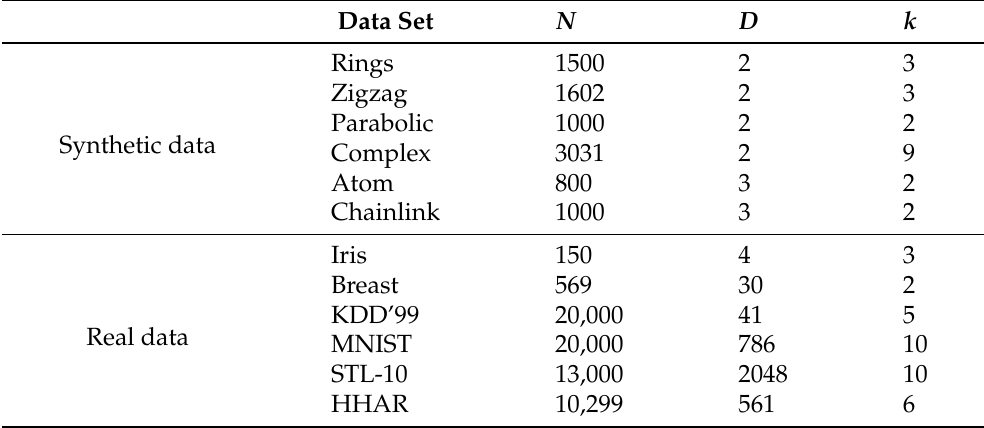
Figure 2. Distributions of synthetic data sets. ( a ) Rings. ( b ) Zigzag. ( c ) Parabolic. ( d ) Complex. ( e ) Atom. ( f ) Chainlink. Table 1. Details of data sets: number of data samples ( N ), number of dimensions ( D ), and number of clusters ( k